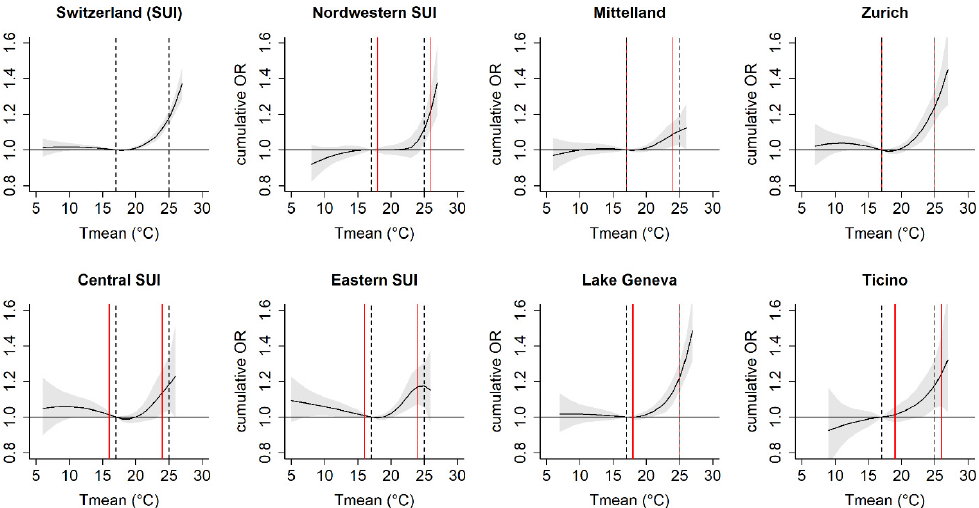
Figure 2. Odds ratios (ORs) of mortality associated with temperature in two time periods (2003–2009 and 2010–2016). ORs with 95% confidence intervals are shown for warm season (May–September) daily mean (Tmean), daily maximum (Tmax), and daily minimum (Tmin) temperature.